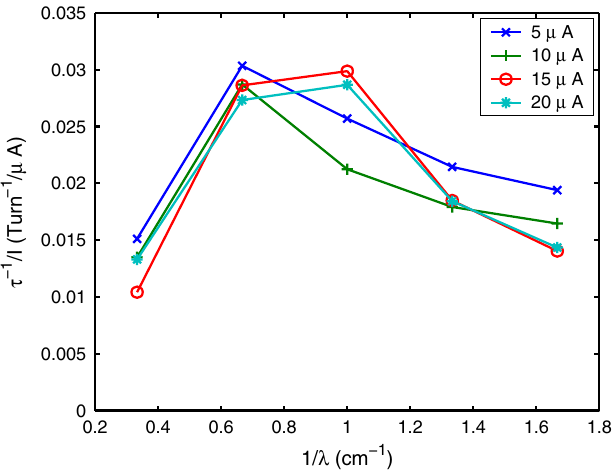
FIG. 11. (Color) Amplitude growth rate for harmonics with the wavelength (cid:9) ¼ 0 : 6 , 0.75, 1, 1.5, and 3 cm normalized to the peak beam current. The normalized growth rate shown for four different peak intensities: 5, 10, 15, and 20 (cid:3) A .